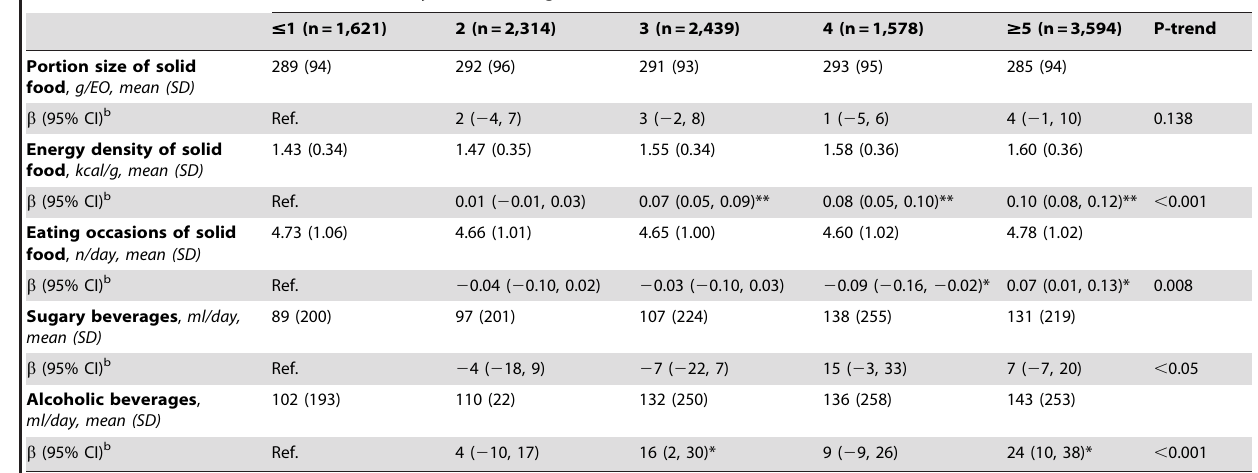
Table 4. Association of the number of obesity-related eating behaviors with portion size, energy density of foods, number of eating occasions, and beverage consumption.